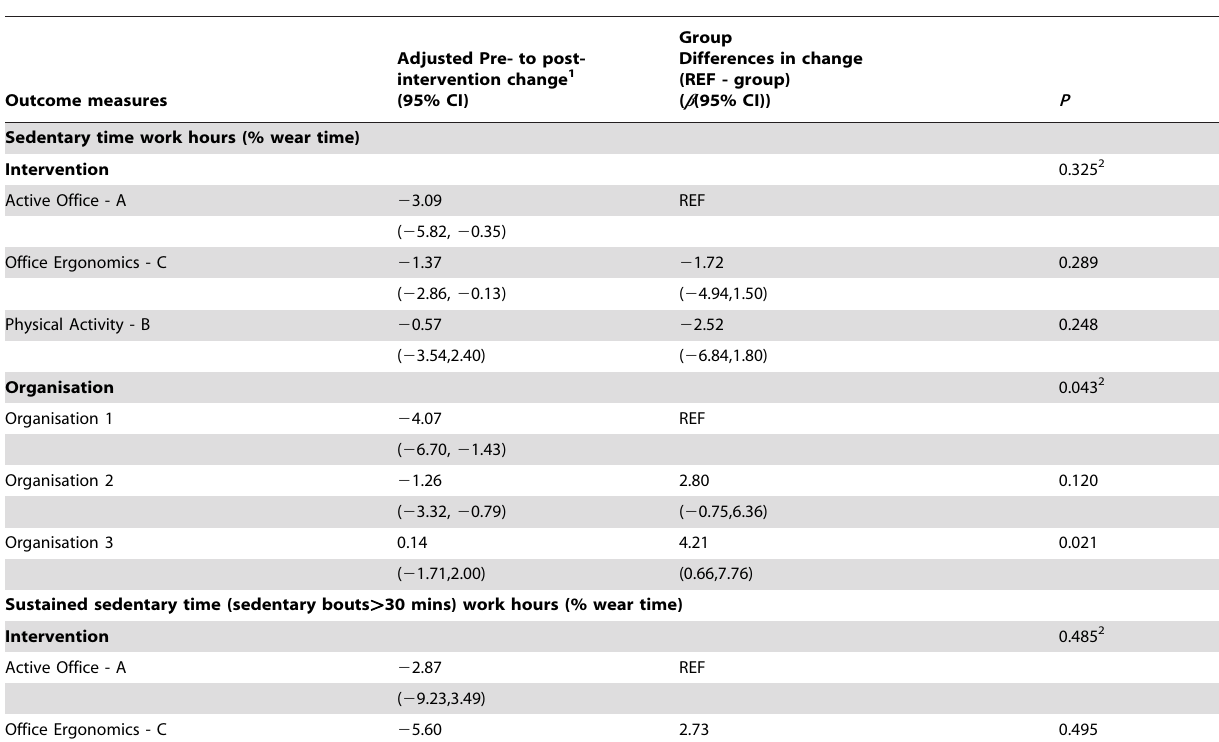
Table 4. Results of multivariable linear regression analysis for sedentary, sustained sedentary, light, moderate/vigorous physical activity time and break rate during work